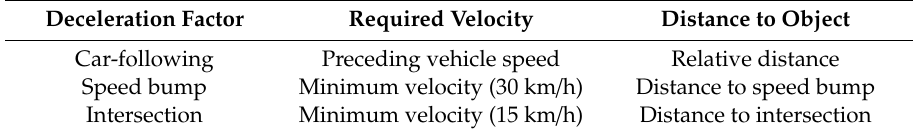
Table 1. Meanings of constant acceleration (CA) model parameters depending on deceleration conditions.